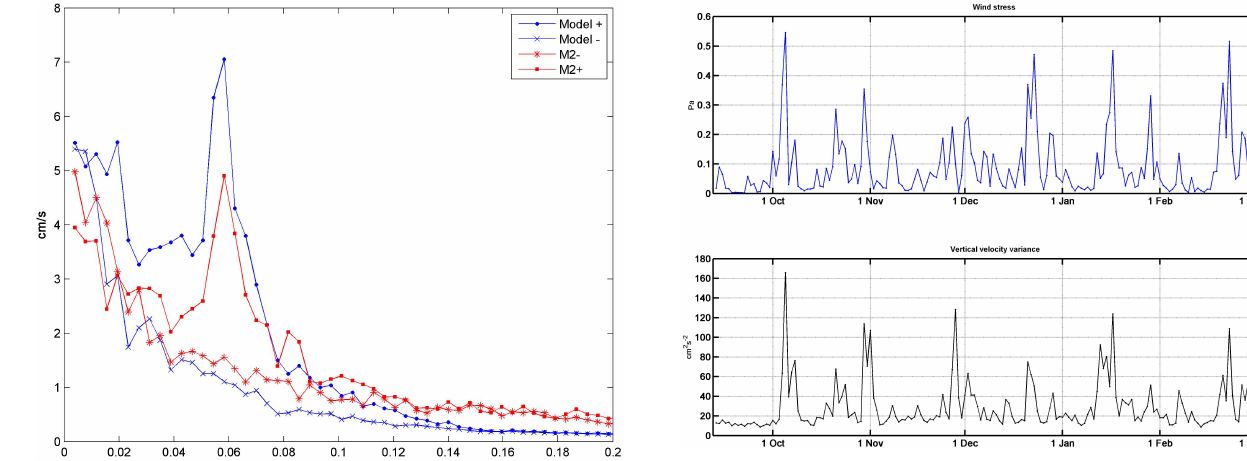
Fig. 18. Comparison of simulated and second mode surface cur- rents: rotary spectrum.